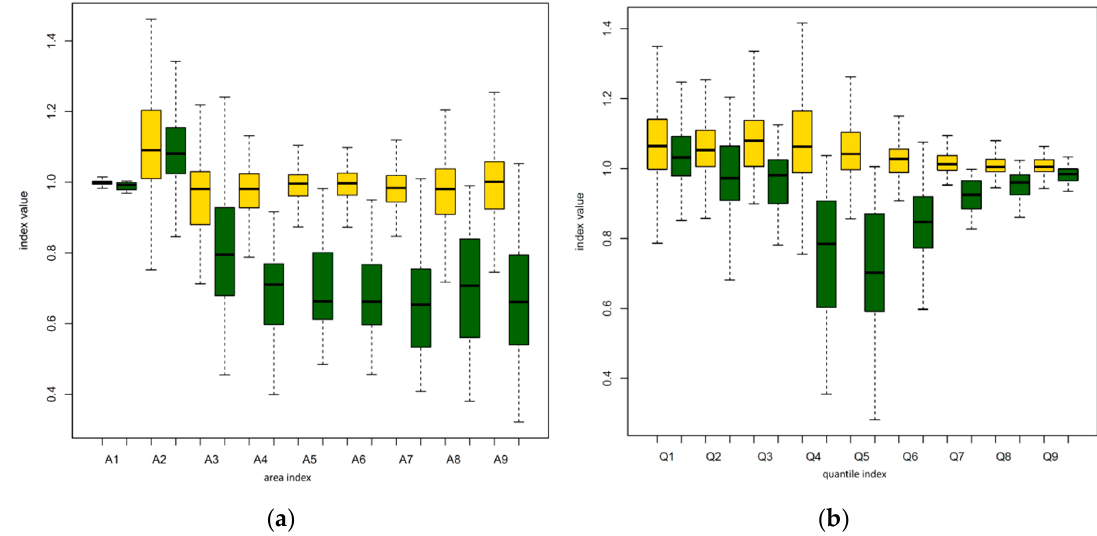
Figure 6. Boxplots for calculated areas ( a ) and quantiles ( b ) along tree lengths; yellow bars represent